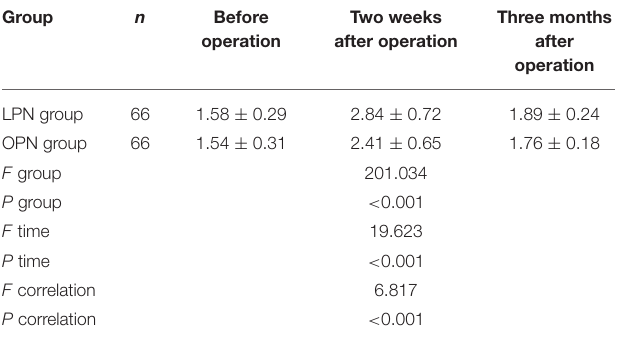
TABLE 2 | Comparison of Cys-C level ( x ± s, mg/L).